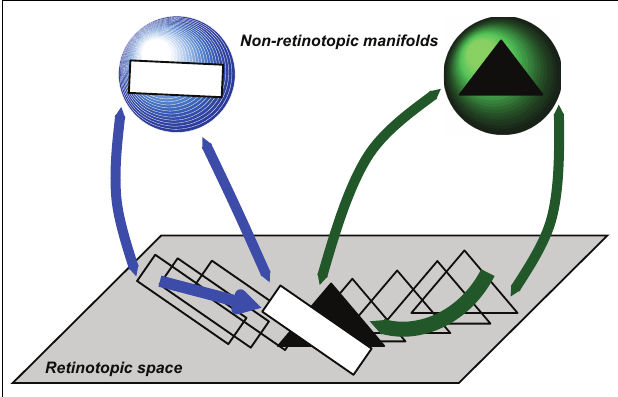
FIGURE 9 | Depiction of how occluded objects are represented and processed. According to this approach, retinotopic areas serve as a relay where features are transferred to non-retinotopic areas according to spatio-temporal grouping relations. A second role of retinotopic areas is to resolve depth order and occlusion relations.While the entire shapes of objects can be accessed from their non-retinotopic representations, visibility of the parts is dictated by retinotopic activities. In this example, observers can recognize a complete triangle (amodal completion) but only those parts that are un-occluded in retinotopic representations become